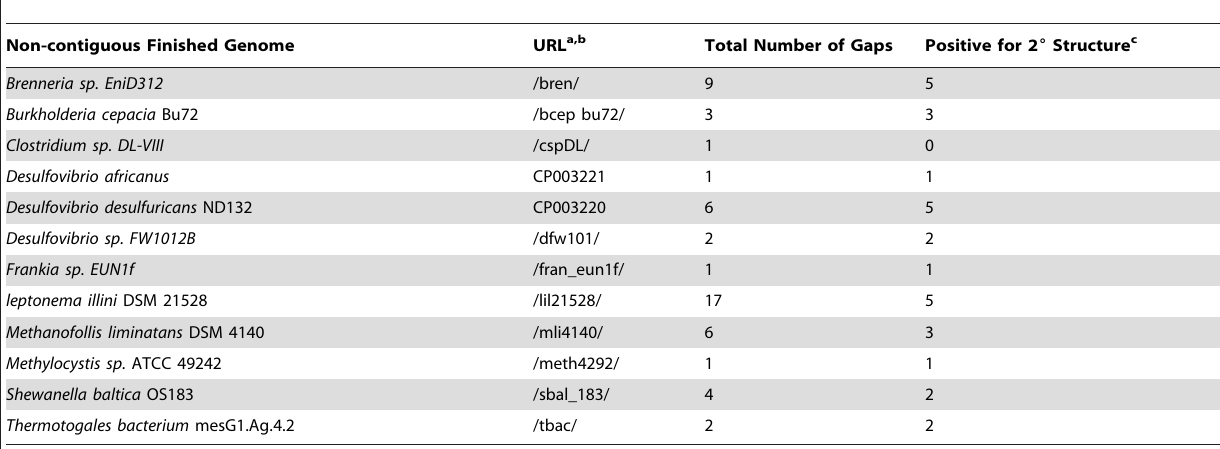
Table 4. Survey of Additional Non-contiguous Finished